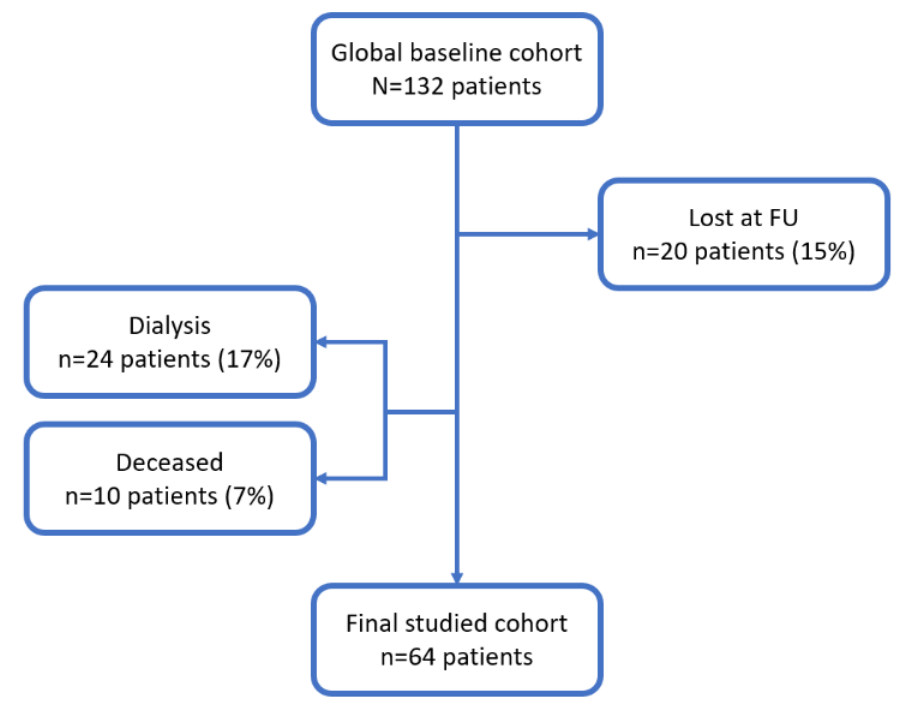
Figure 1. Population selection criteria .